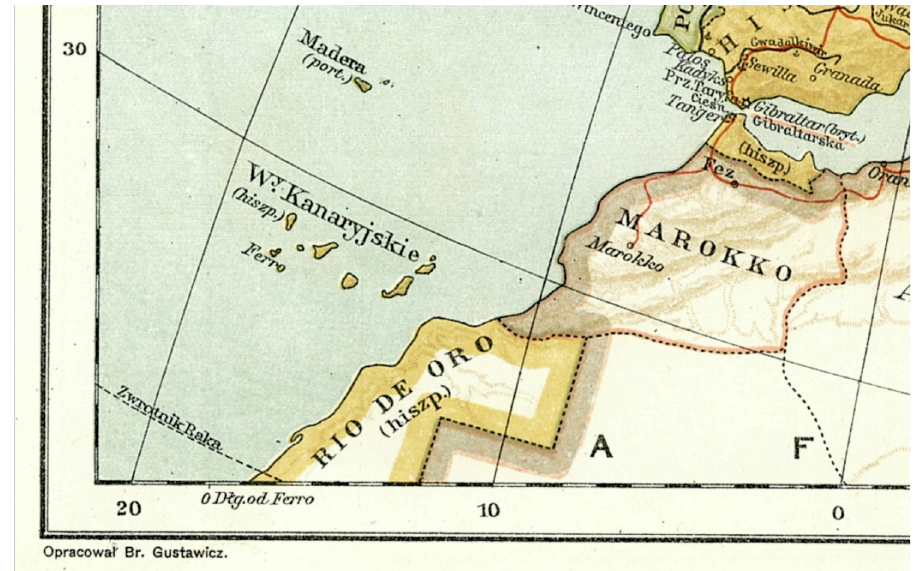
Fig. 3. A part of the map of Europe with the description of the graticule lines in the Greenwich system and the location of the Ferro Meridian from the Atlas geograficzny dla szkół średnich (Geographical atlas for secondary schools) by B. Gustawicz, 1925 [12], pp.